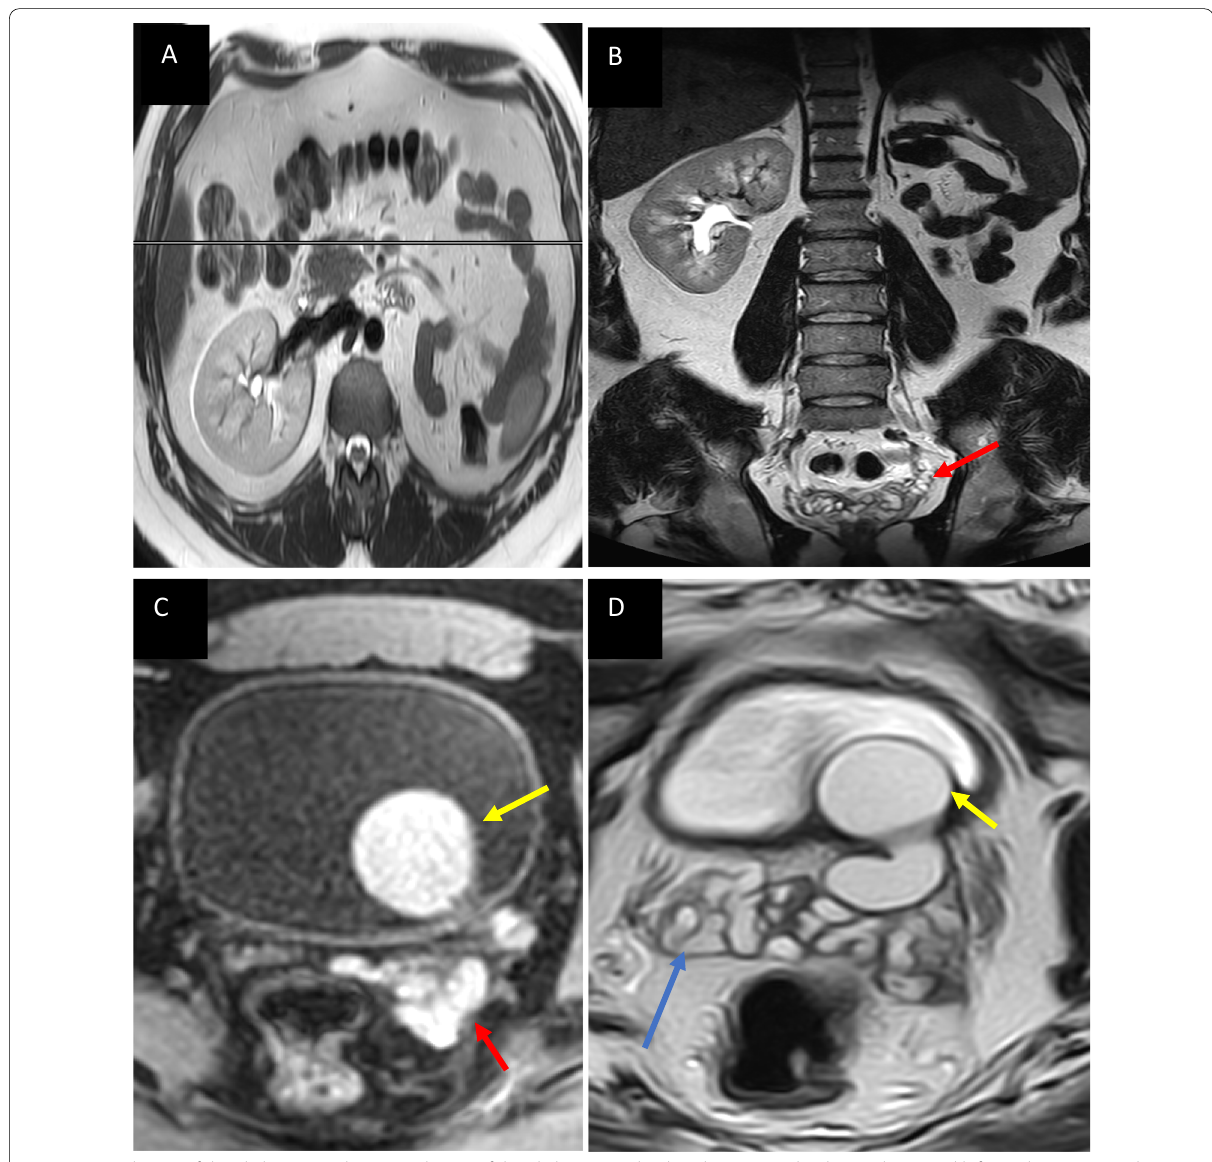
Fig. 1 A Axial T2WI of the abdomen and B coronal T2WI of the abdomen and pelvis show normal right renal unit and left renal agenesis and tubular cystic structure at the left side of the pelvis (red arrow), C and D high‑resolution axial fat‑suppressed T1WI and axial T2WI of the pelvis revealed normal right SV (blue arrow) and dilated left one with cyst (yellow arrow) measured (2.5 2.2 cm) compressing the left posterolateral × vesical wall anteriorly, both of the cyst and the tubular structure display high SI at both T1WI and T2WI denoting hemorrhagic content, E and F high‑resolution coronal T2WI of the pelvis show the left SV cyst with dilated ED (white arrow) as well as presence left sided pelvic cystic tubular structure (red arrow) is seen connected with the dilated left SV which resembles left ureteric bud with abnormal insertion with left SV, G and H high‑resolution left parasagittal T2WI of the pelvis confirms the same